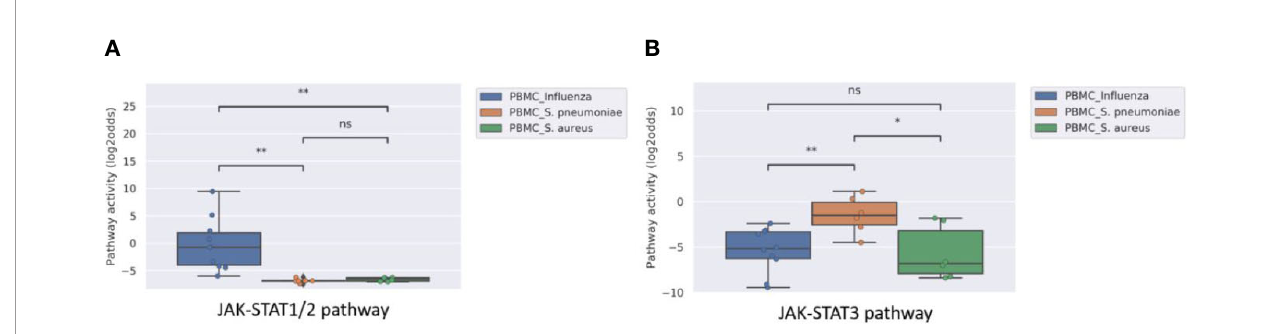
FIGURE 1 | JAK-STAT1/2 (A) and STAT3 (B) pathway activity analysis of dataset GSE6269 (34) containing Peripheral Blood Mononuclear Cell (PBMC) samples of pediatric patients with acute infection with in fl uenza virus (blue), S. Pneumoniae (orange), or S. Aureus (green). Pathway activity score on Y-axis in log2odds. Two